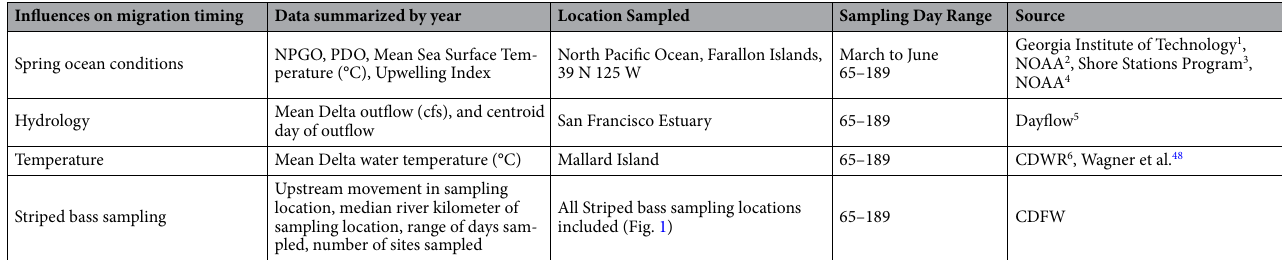
Upstream movement in sampling All Striped bass sampling locations location, median river kilometer of included (Fig. sampling location, range of days sam- pled, number of sites sampled Table 3. Data sources for the main effects relating to the environmental conditions in the estuary and coastal ocean as well as the sampling design of the IEP Striped bass Population Study, which were then tested for influences on Striped bass yearly median migration date. 1 https:// www. o3-d. org/ npgo/ npgo. php; accessed 13